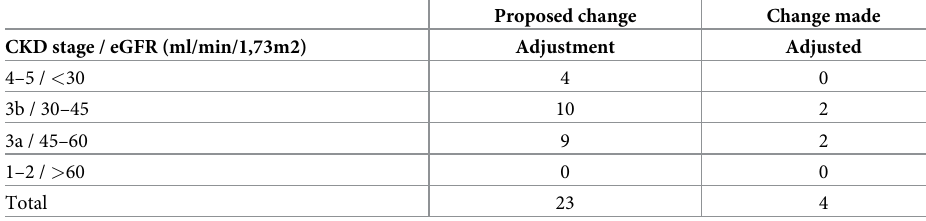
Table 9. Number of patients for whom dose adjustment is proposed and those for whom it is adjusted. Proposed change Change